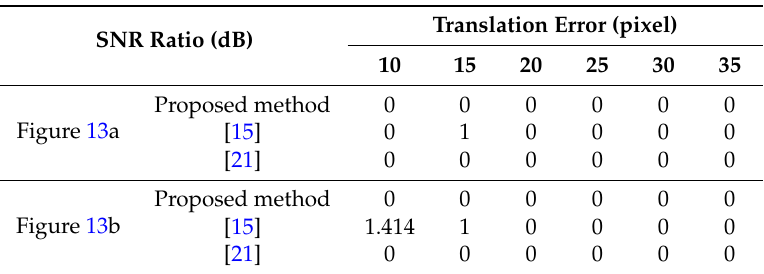
Figure 14. Rotation errors for the matching results with Gaussian noise. ( a ) The case of Figure 13(a); Table 3. Translation error for the matching results with Gaussian noise. ( b ) The case of Figure 13(b). Table 3. Translation error for the matching results with Gaussian noise.